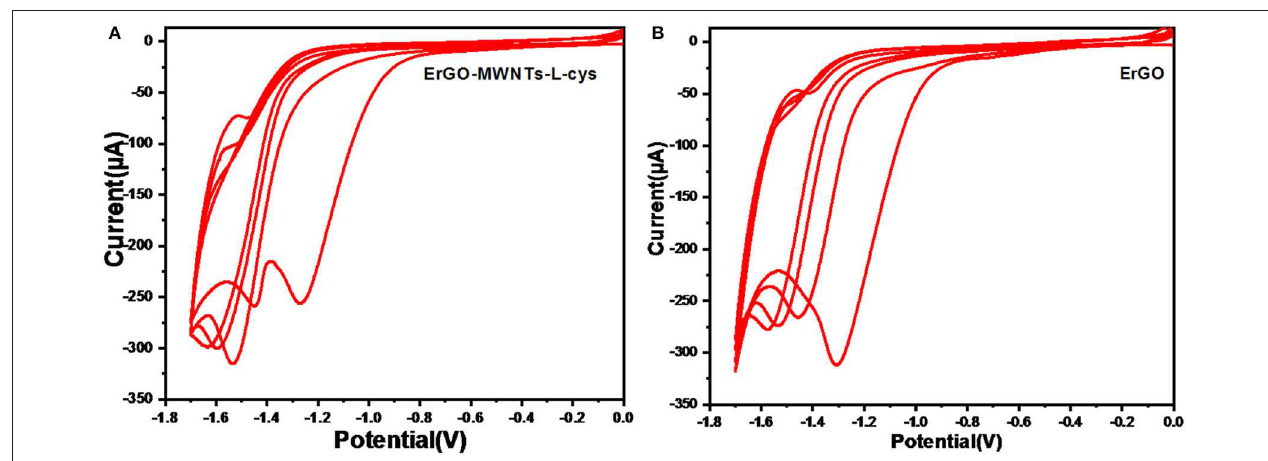
FIGURE 6 | Cyclic Voltammograms (CVs) with 0.05 Vs − 1 scan rate for the electrochemical reduction of GCE modified with: (A) GO–MWNTs–L-cys nanocomposite and (B) GO sheets; in 0.1M acetate buffer solution (pH 4.5) saturated with nitrogen gas. The range is between 0 and − 1.7 V.